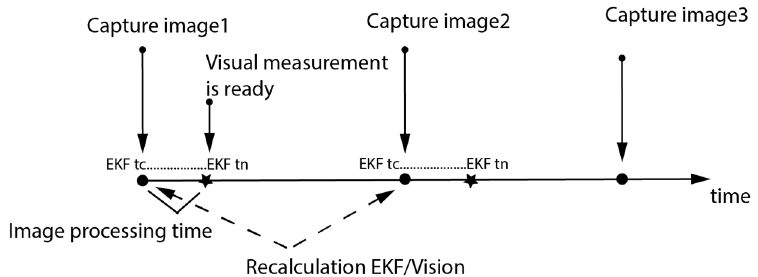
Figure 3. Recalculation using EKF. When a vision measurement was ready, the EKF was recalcu- lated from the capturing moment to the actual moment (t n -t c ) after updating the state with visual measurements at “t c ”. Otherwise, the EKF was carried out between the INS and the barometer only.